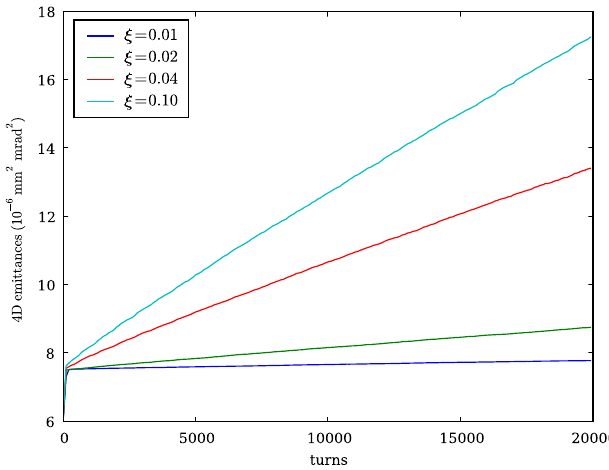
FIG. 10. (Color) The evolution of 4D emittances for beam-beam parameters of 0.01, 0.02, and 0.04 which correspond to inten- sities of (a) 2 : 2 (cid:2) 10 11 , (b) 4 : 4 (cid:2) 10 11 , (c) 8 : 8 (cid:2) 10 11 , and (d) 1 : 1 (cid:2) 10 12 protons per bunch.